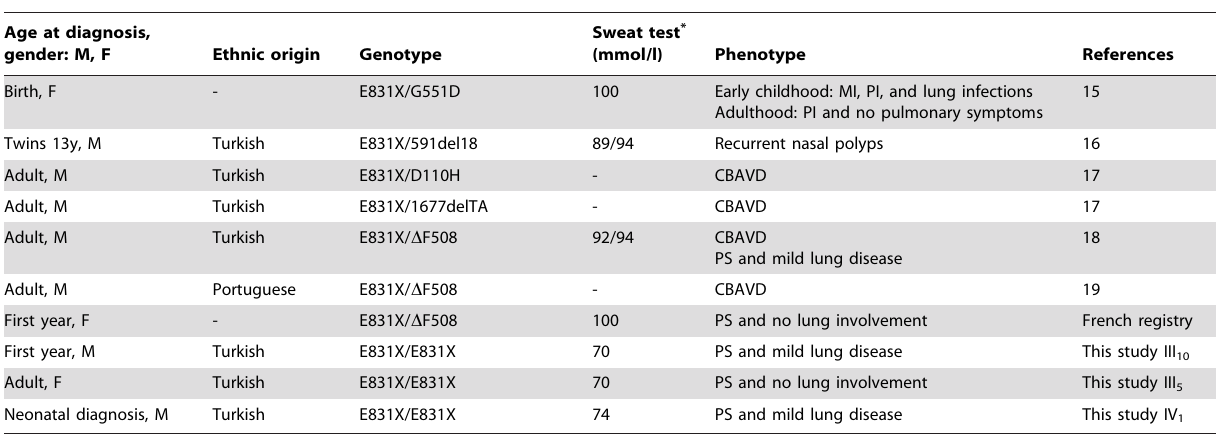
Table 1. Phenotypes associated with E831X mutations.